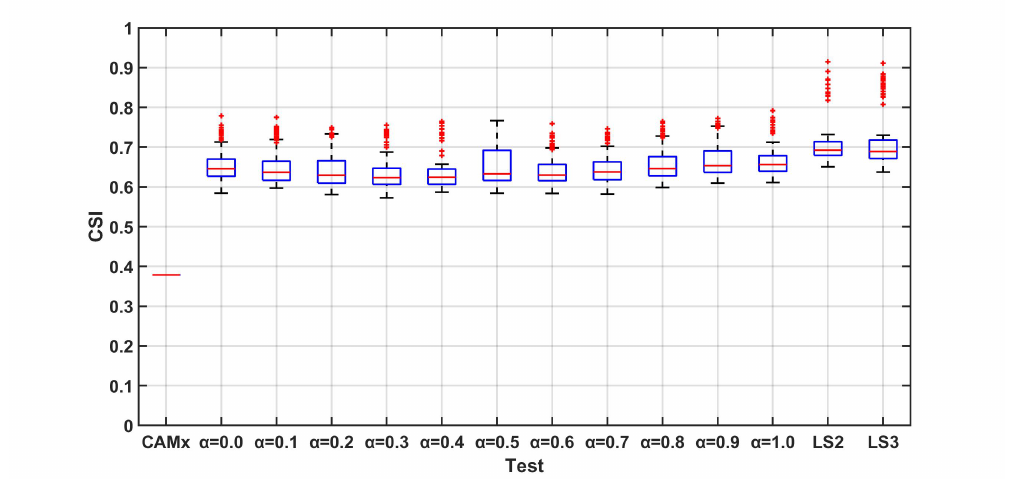
Figure 11. SI for the two-step-forward forecast.